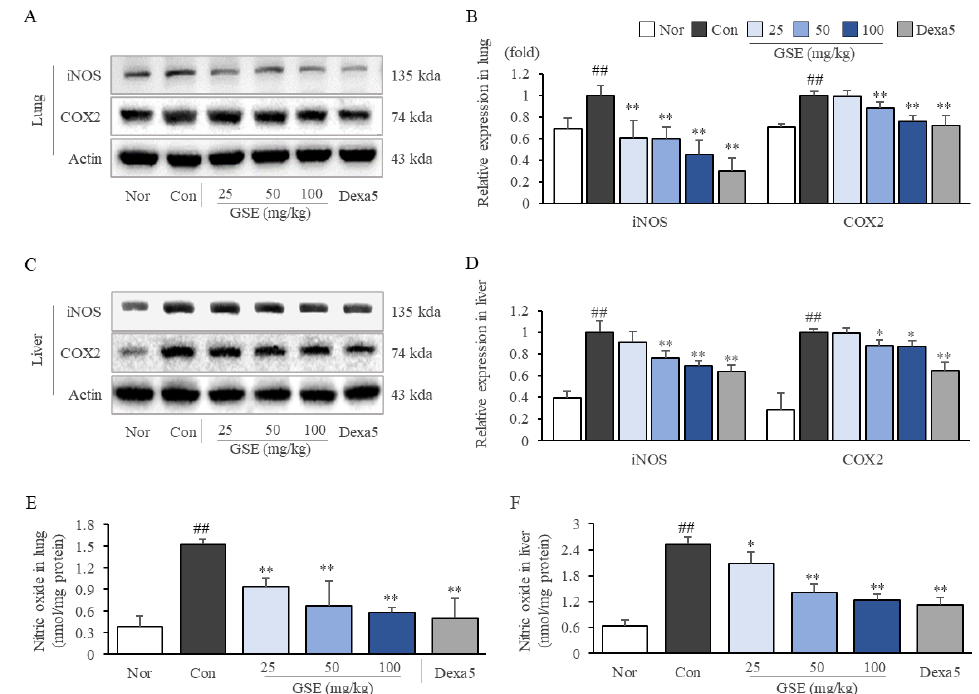
Figure 4. Effects of GSE on inflammatory mediators in pulmonary and hepatic tissues. The protein levels of iNOS and COX2 in the lung ( A , B ) and liver (C, D ) tissues were assessed by Western blot, band intensities were quantified by ImageJ. Nitric oxide levels in lung ( E ) and liver ( F ) tissues were evaluated with the Griess reaction. Samples were grouped according to treatment: normal (Nor), control (Con), ginseng sprout extract (GSE), and dexamethasone (Dexa5). The data are presented as the mean ± SD. ## p < 0.01 compared with the normal group; * p < 0.05, ** p < 0.01 compared with the control